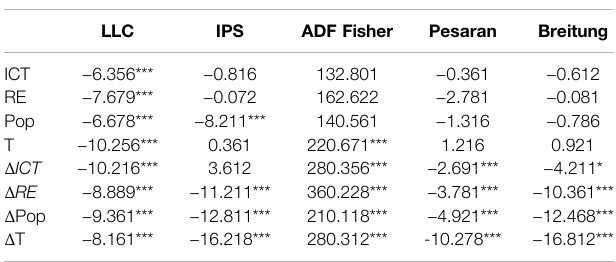
TABLE 3 | Panel unit root test.